Question: In a single sentence, describe what this figure presents.
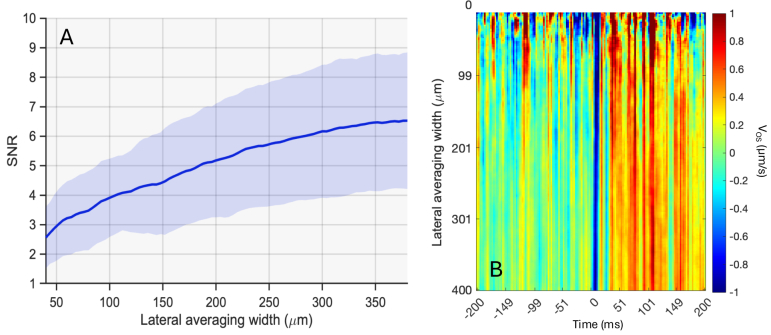
Answer: Impact of spatial averaging on ORG. A) SNR as a function of lateral averaging for unfiltered single ORG measurements, summarized across subjects in the low NA 2° condition. B) Velocity ORG signal as a function of lateral averaging for one subject, where blue represents negative ORG velocity (contraction), while red represents positive ORG velocity (elongation).